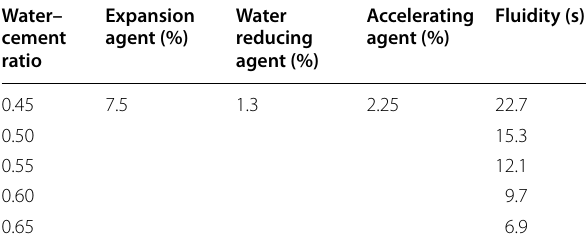
Table 5 Laboratory test for determining test level of water– cement ratio Water–